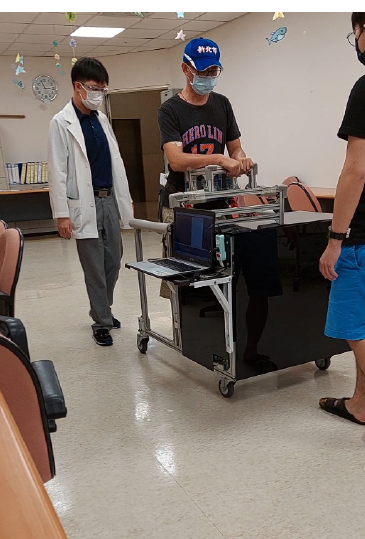
Figure 8. Clinical rehabilitation training by the NDT trainer.